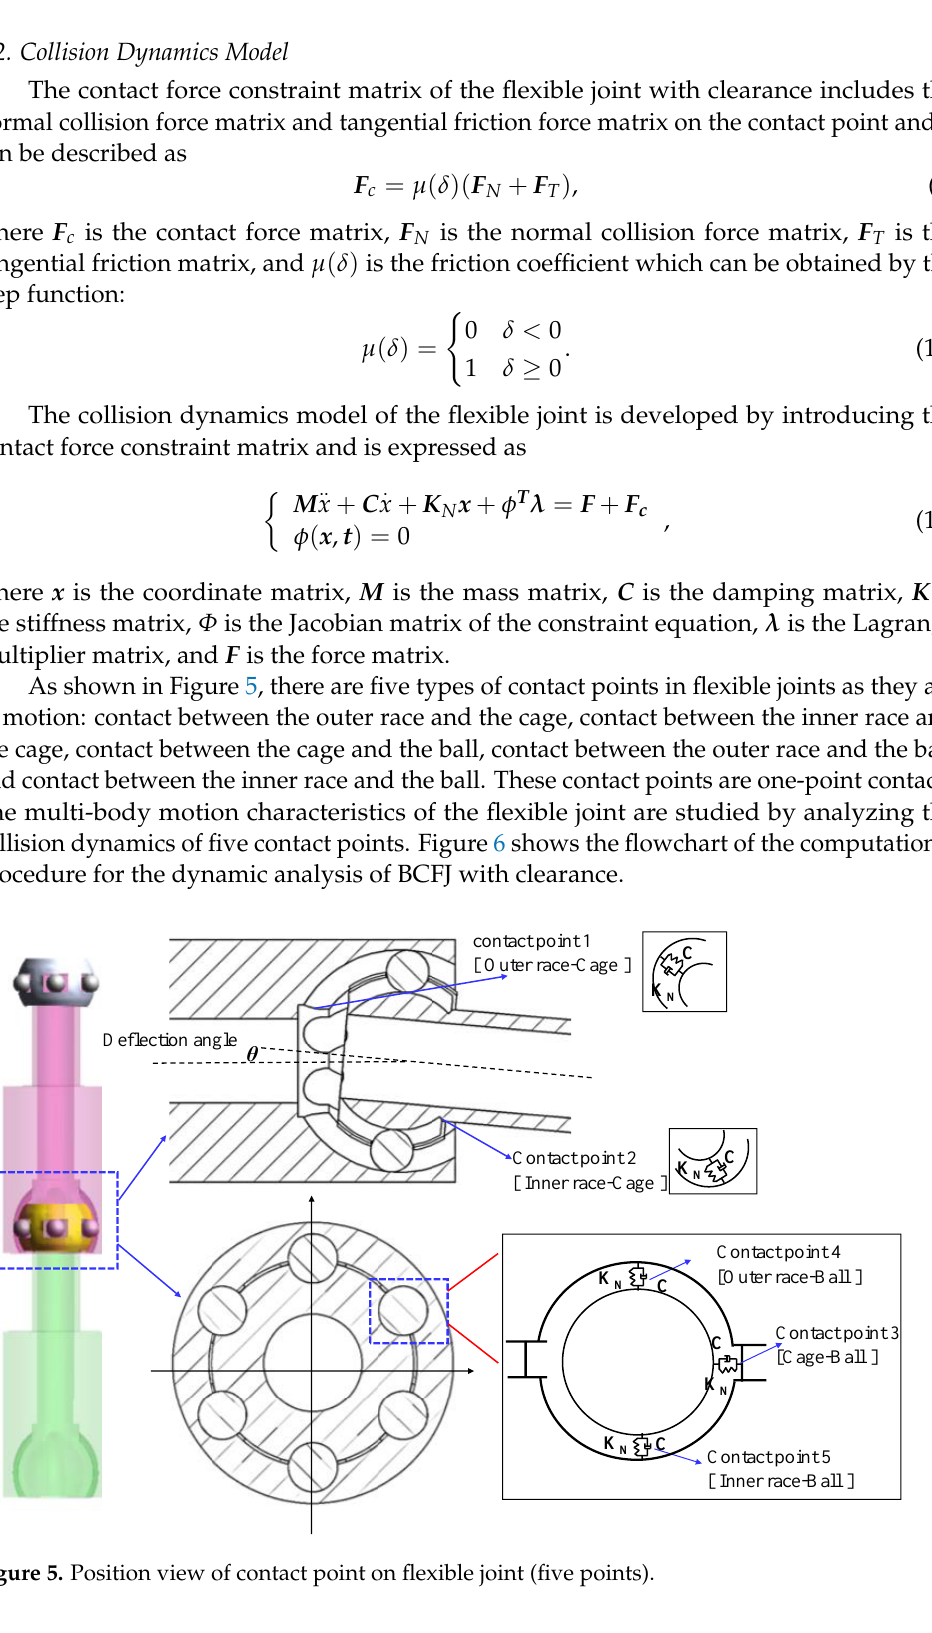
Figure 6. Flowchart of computational procedure for dynamic analysis of BCFJ with clearance. 4. Results and Discussion In the process of ultra-short radius drilling, the state of the ball cage universal joint is constantly changing between separation and connection. The ball key, cage, ball head, ball seat, and other mechanisms collide with each other, resulting in contact constraints. Figure